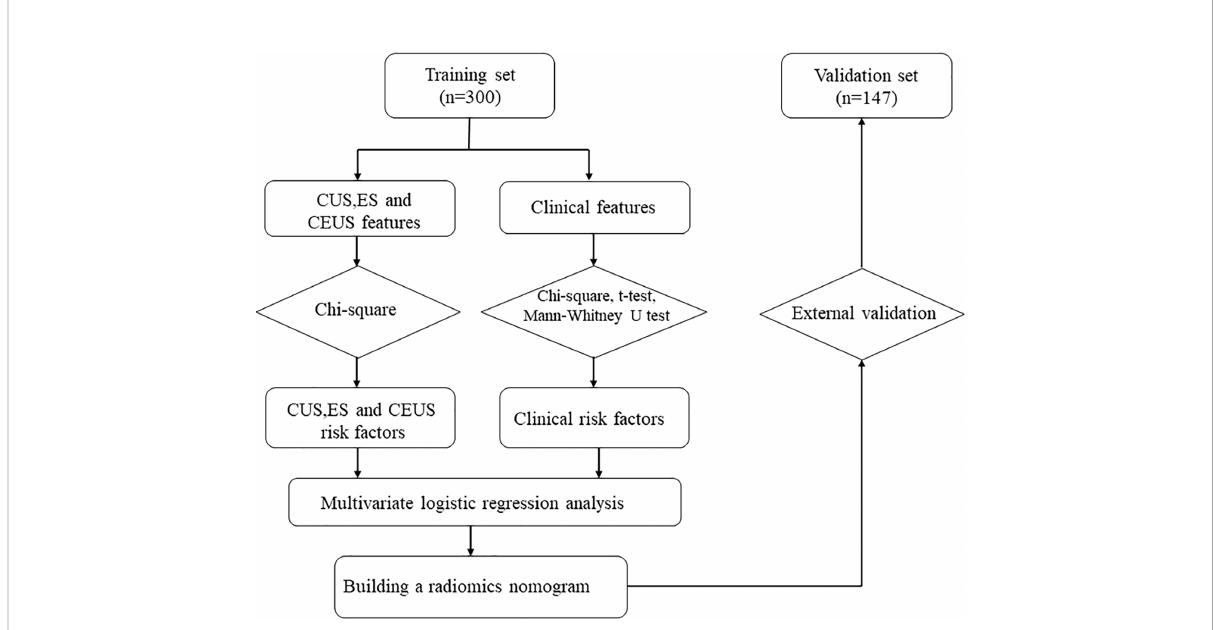
FIGURE 2 Flowchart of study method CUS, conventional ultrasonography; CEUS, contrast-enhanced ultrasonography; ES,